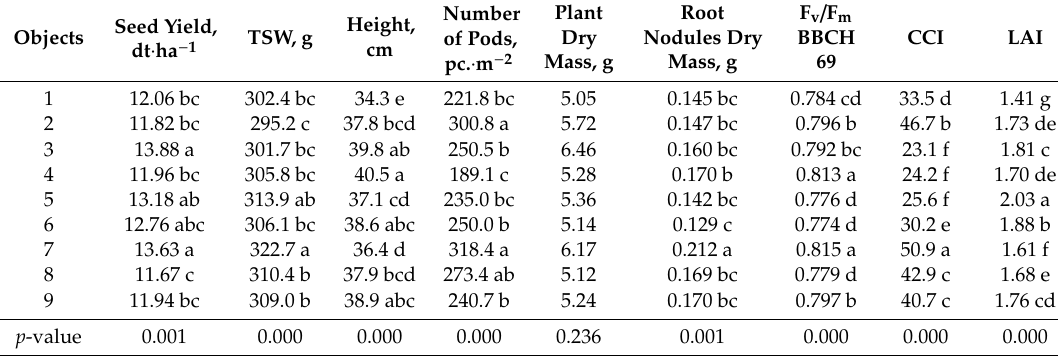
1. control—no bio-stimulants or foliar fertilizers applied to the plants; 2. plant + Tytanit; 3. plant + Optysil; 4. plant + Metalosate potassium; 5. plant + Rooter; 6. plant + Bolero Mo; 7. plant + ADOB Zn IDHA; 8. plant + ADOB B; 9. plant + ADOB 2.0 Mo; lack of homogeneous groups means no significant di ff erences at the level of p < 0.05, a, b, c, d, e, f, g-homogeneous groups (Duncan’s test. p < 0.05); TSW-thousand seed weight, F v / F m —maximum